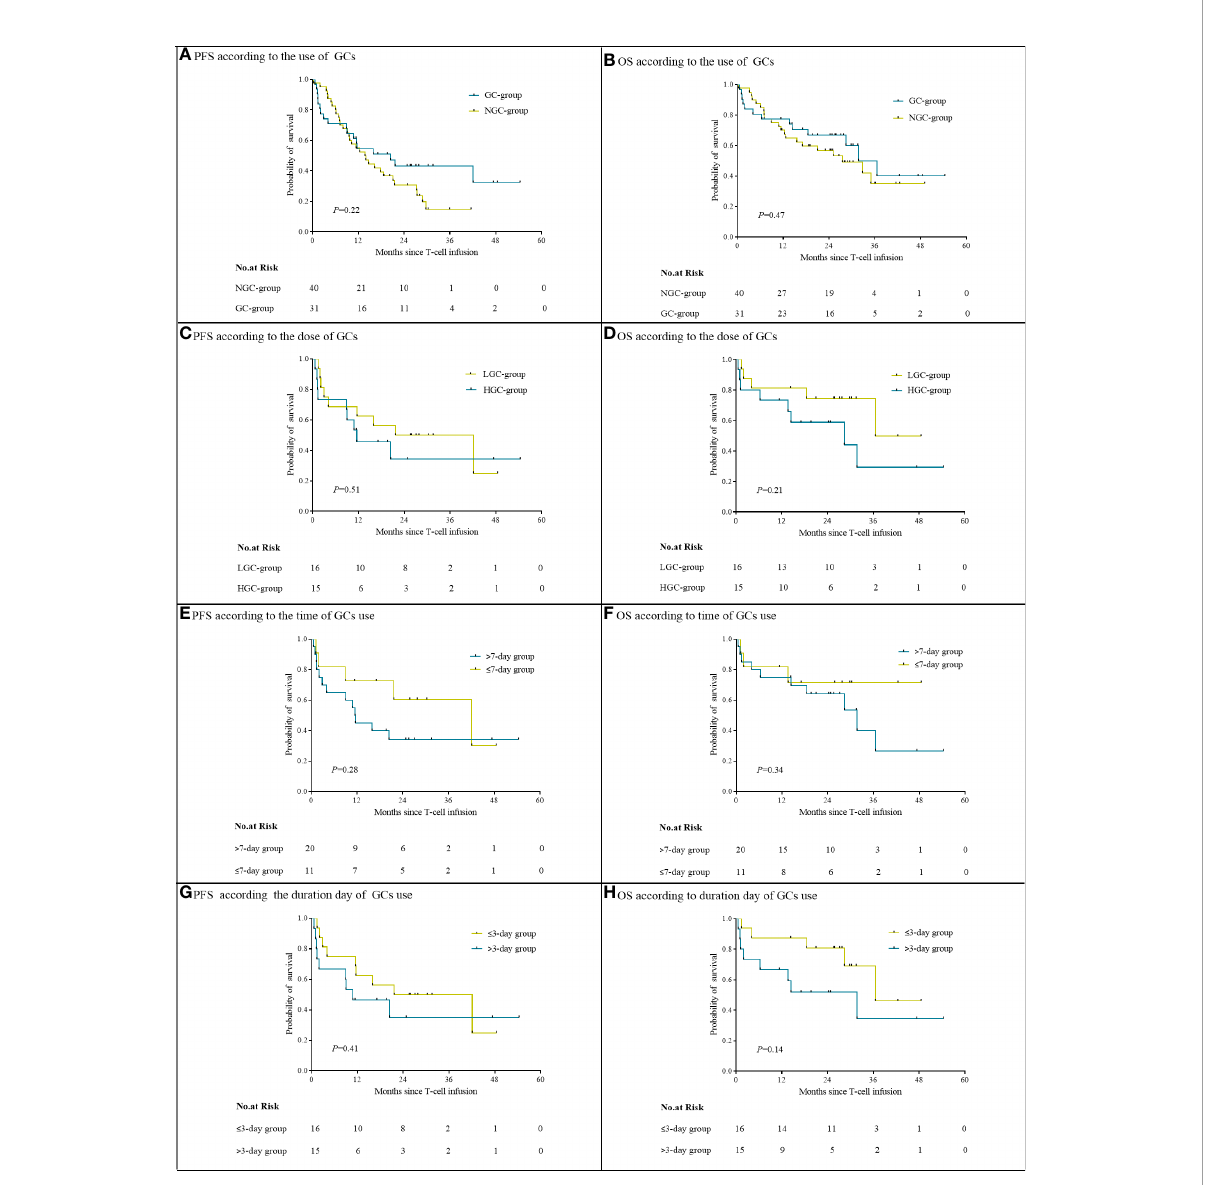
FIGURE 3 Progression-free survival and overall survival, according to use of GCs (A, B) , cumulative GC dose (C, D) , timing (E, F) , and duration (G, H)